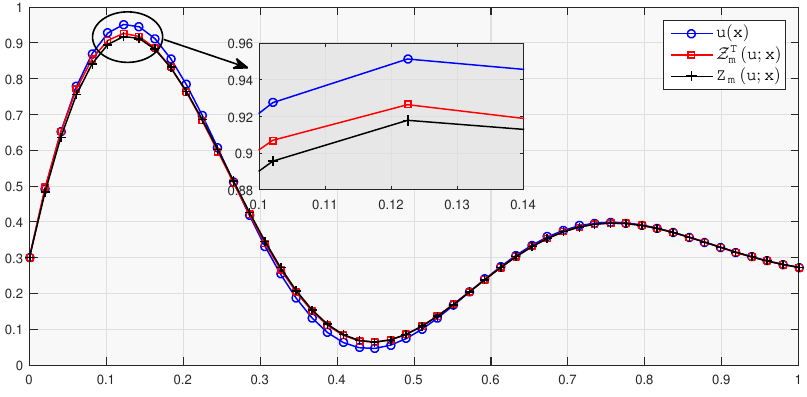
Figure 1. Test function (Blue-Circle), standard Meyer–König and Zeller operator (Black-Plus), and new construction of Meyer–König and Zeller operator (Red-Square) with the given parameters, r m ( x ) , s m ( x ) , and τ ( x ) on uniform